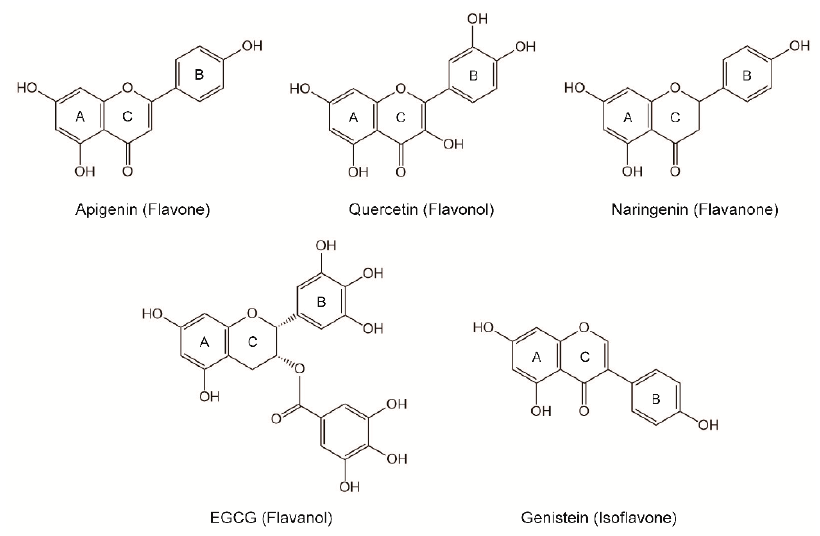
Figure 1. Structures of the flavonoids considered in the current study.